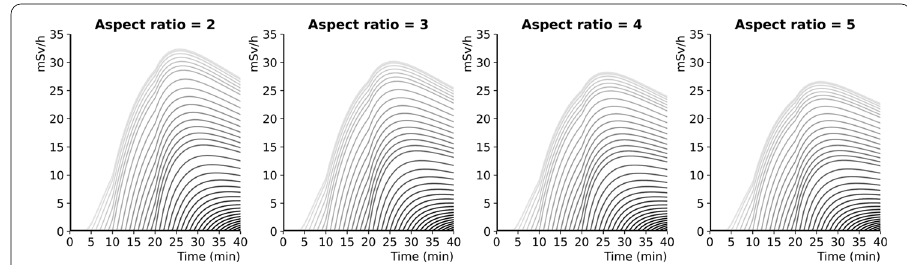
Fig. 7 Evolution of simulated EDR at the patient’s arm for infusions that extravasate with onset times ranging from 1 to 40 min with 1-min sampling (gray curves) and for four elliptical aspect ratios (2, 3, 4 and